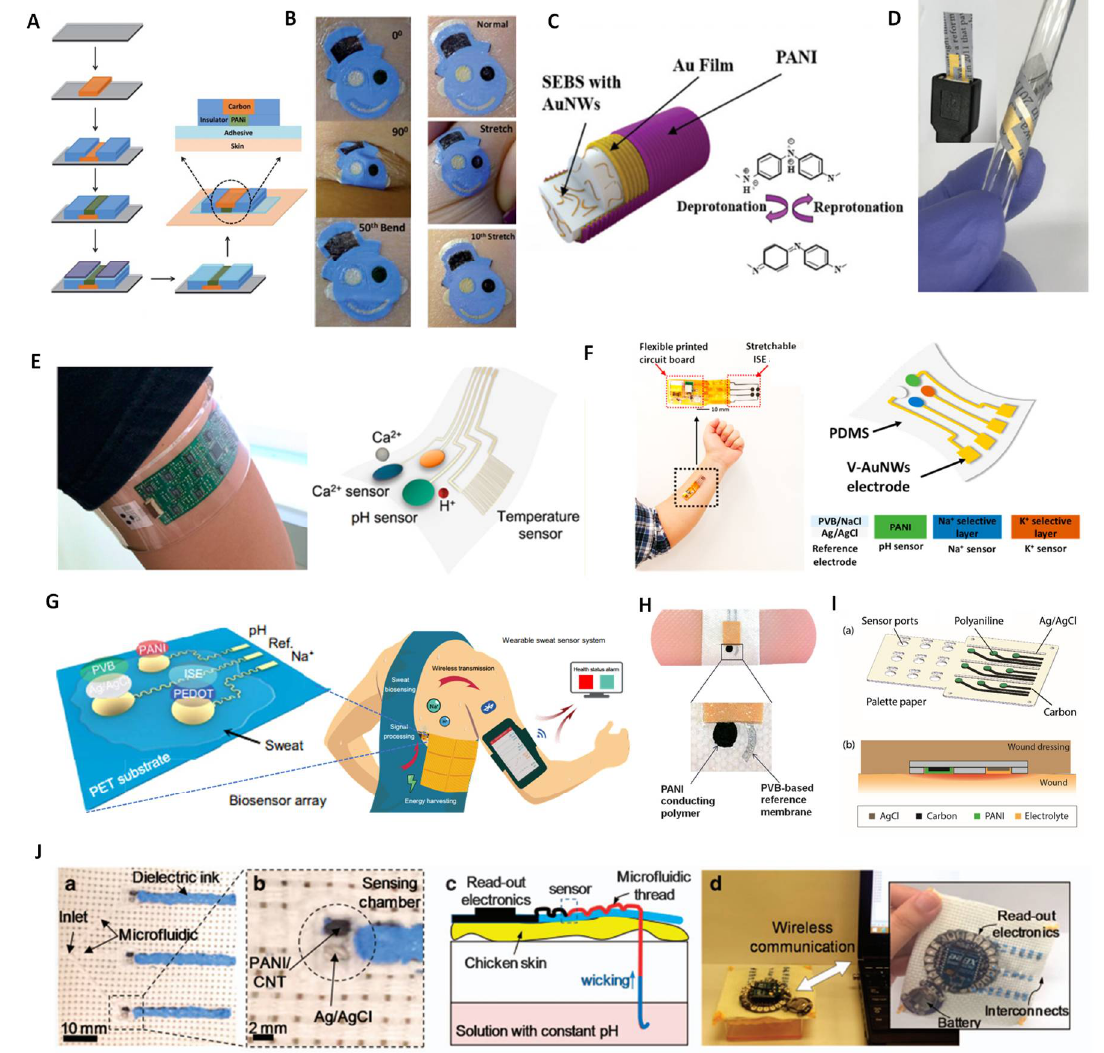
Figure 2. PANI−based wearable pH sensors. ( A ) The fabrication steps for PANI−based pH sensors on a tattoo substrate. ( B ) The tattoo applied to the cubital fossa at different bending and stretching states and cyclic tests. Reprinted with permission from [54], Copyright (2013) Royal Society of